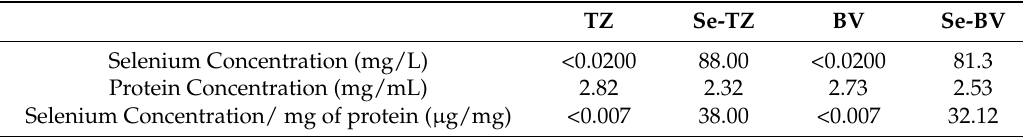
Table 1. Selenium and protein concentration of native and selenium immunoconjugates following dialysis.